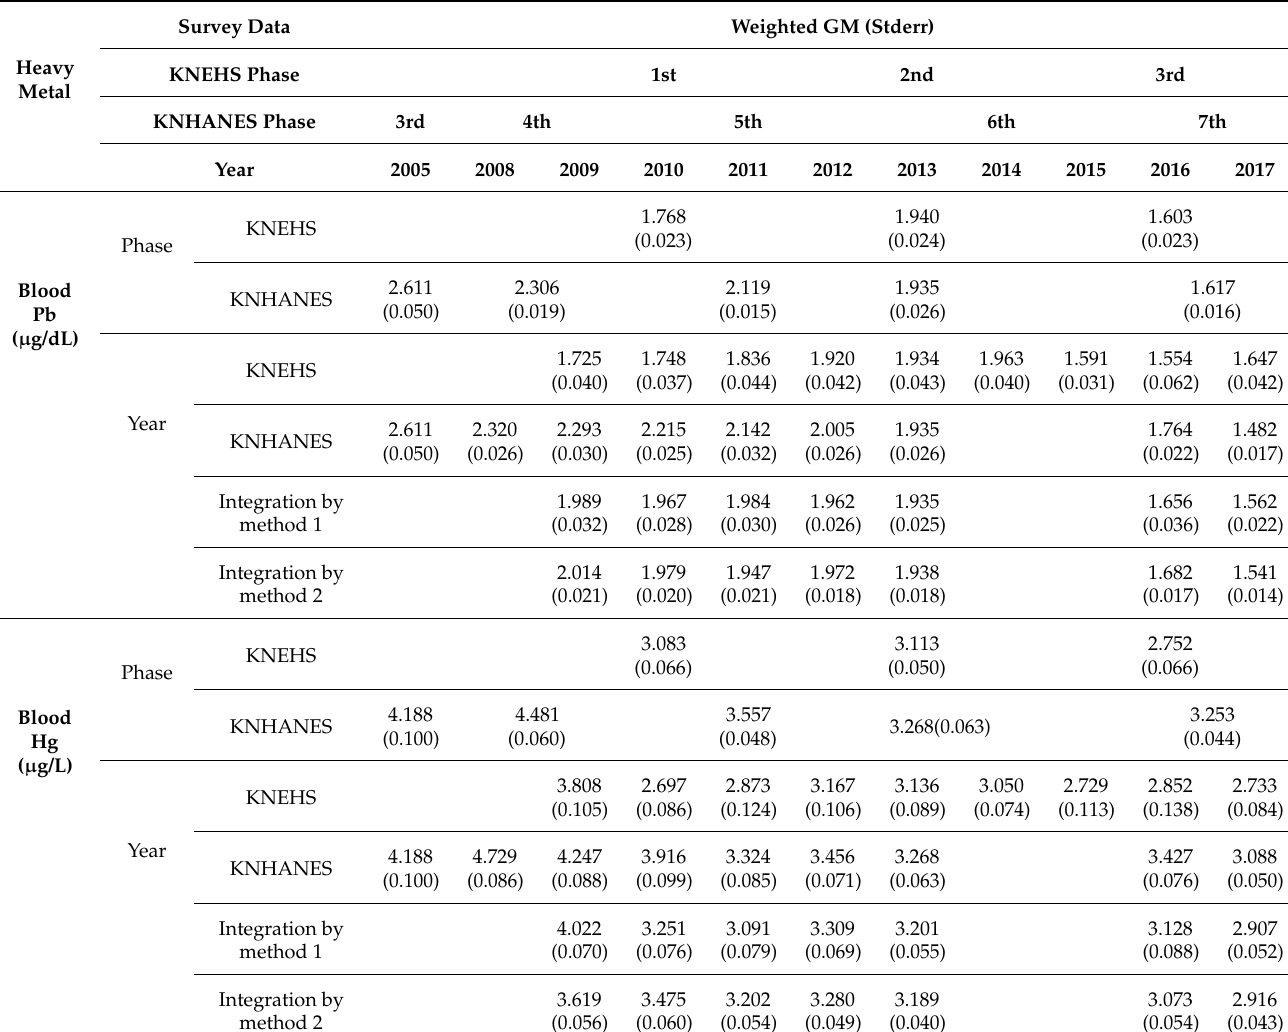
Table 1. Compositional